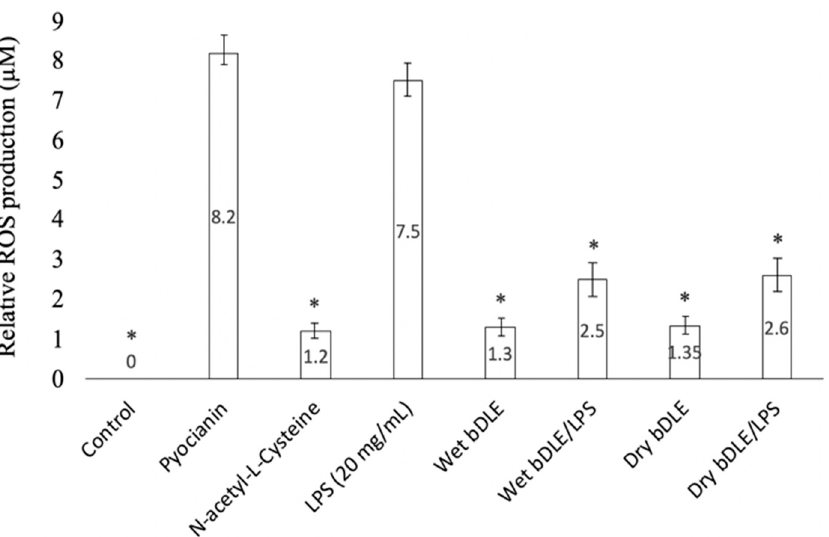
Figure 8. Effect of wet and dry bDLE on ROS production by LPS stimulated PBMC. PBMC (5 × 10 5 ) unstimulated or stimulated with LPS (100 ng/mL) were treated with wet and dry bDLE for 5 h. ROS levels were determined by fluorescence as measured in a multi detection reader (Bio-Tek Instruments Inc. Winooski, VT, USA). N-acetylcysteine (NAC) at a 5 mM was used as a ROS inhibition control and pyocyanin at a 400 μ M was used as a ROS positive inducer control. Statistical significance was determined by one-way ANOVA followed by the Dunnett’s post hoc test (* p < 0.05).